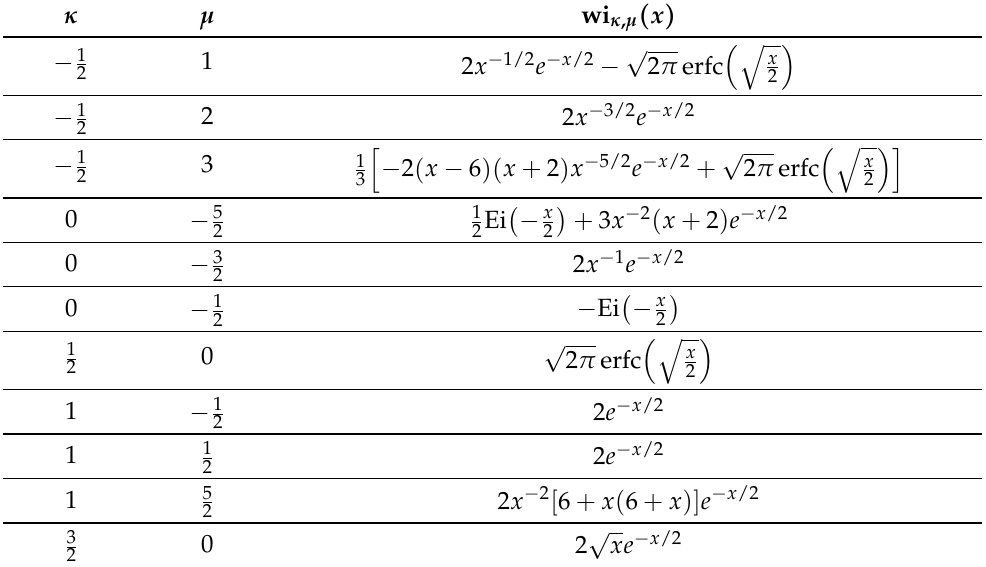
Table 9. The integral Whittaker functions wi κ , µ derived for some values of parameters κ and µ by using (18) and